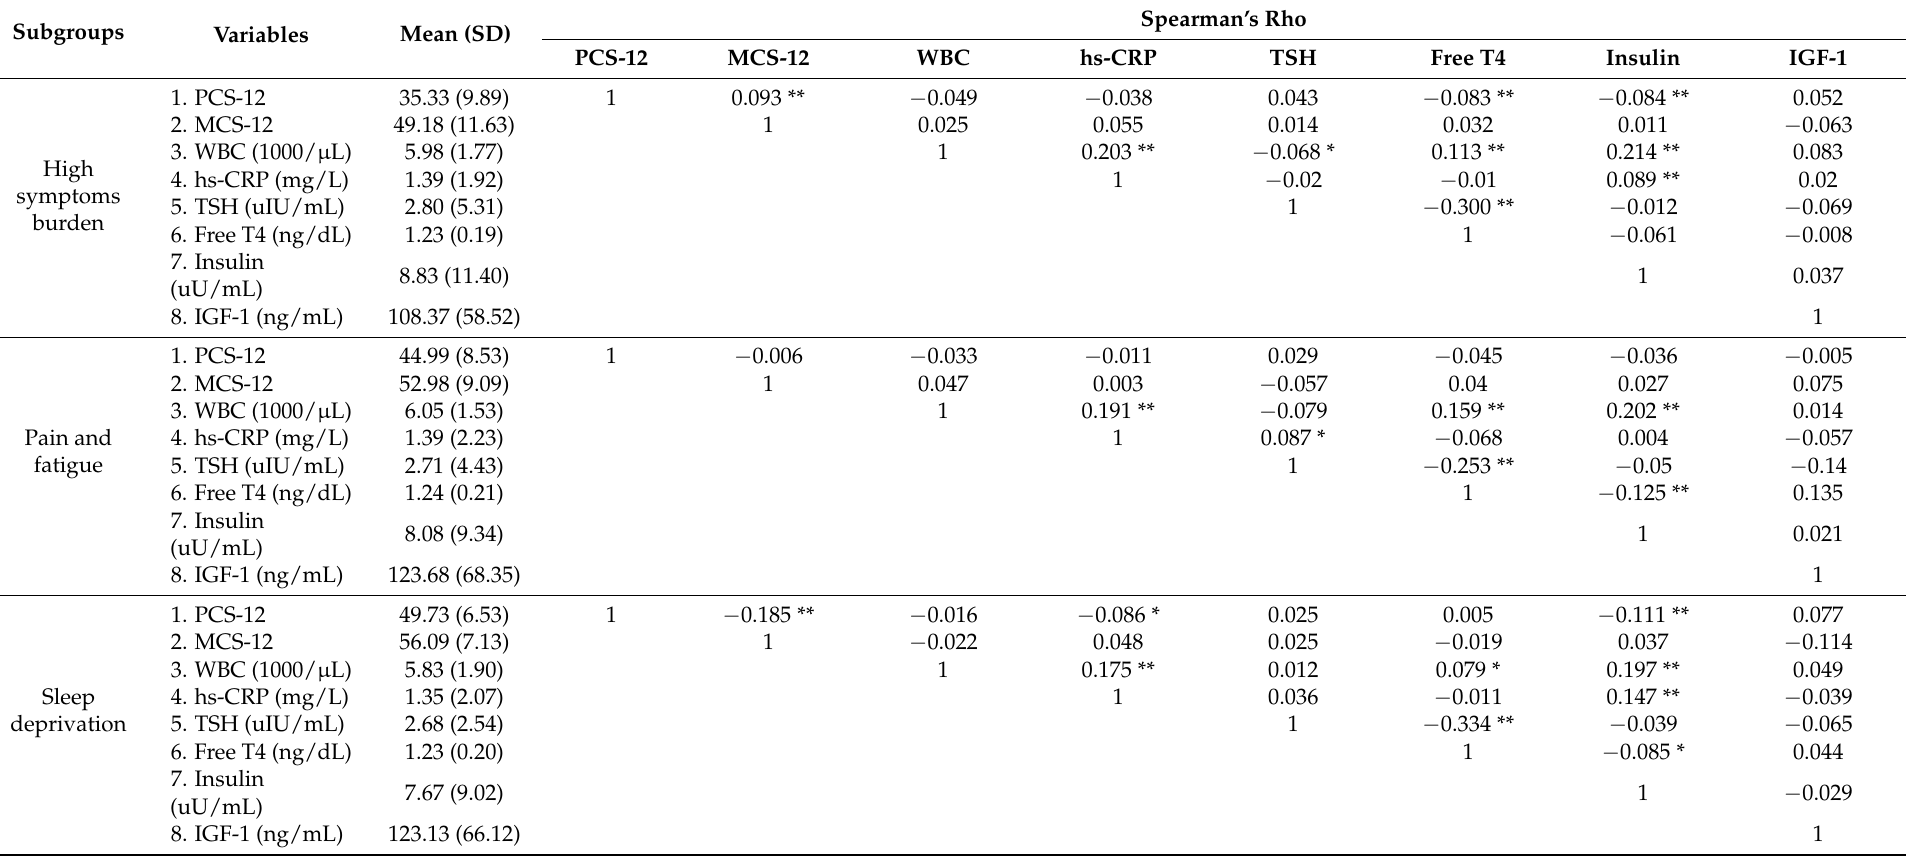
Table 4. Associations of symptom clusters, health-related quality of life, and clinical blood